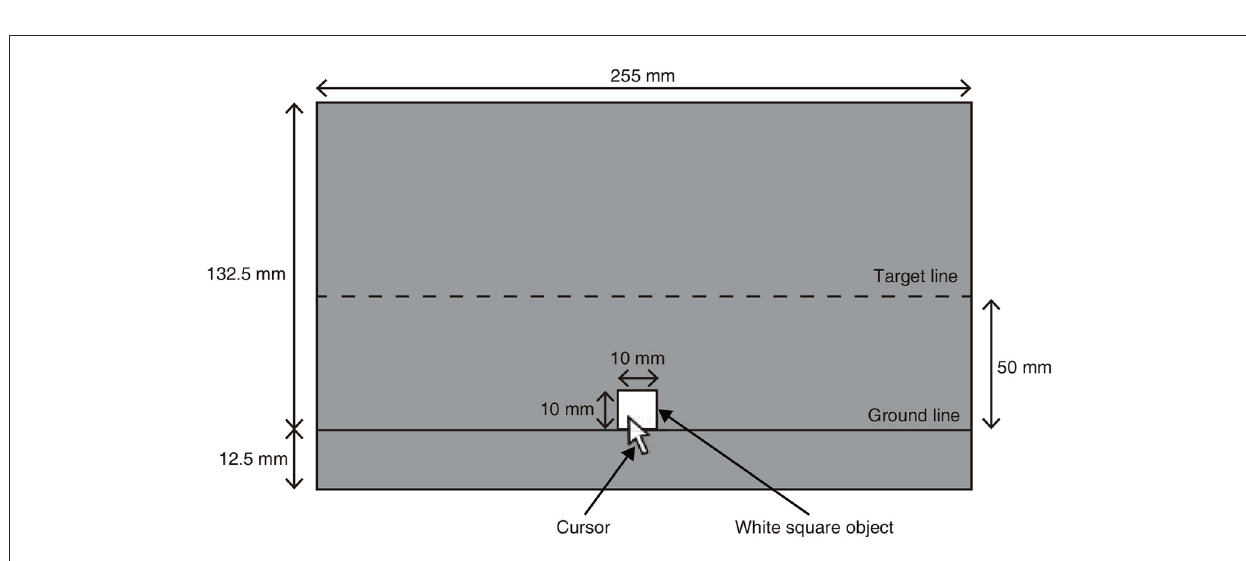
FIGURE2 Experimental